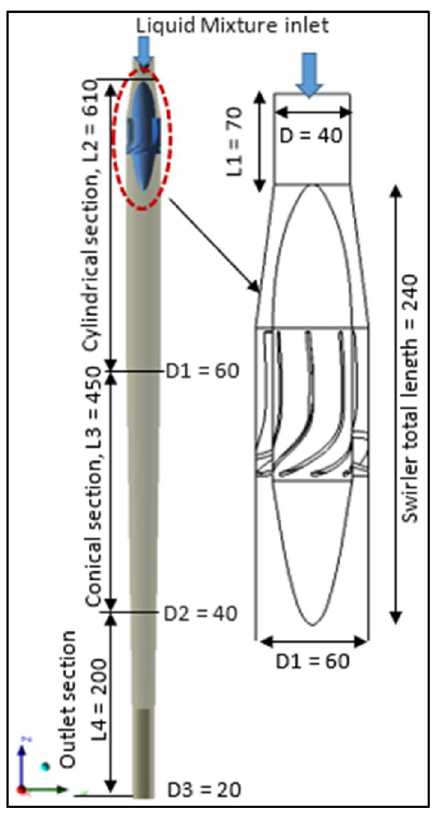
Fig. 2 Model geometry of an axial inlet hydrocyclone separator with a swirl generator inside (left) and enlarged section of the swirl gen- erator (right). [All dimensions in